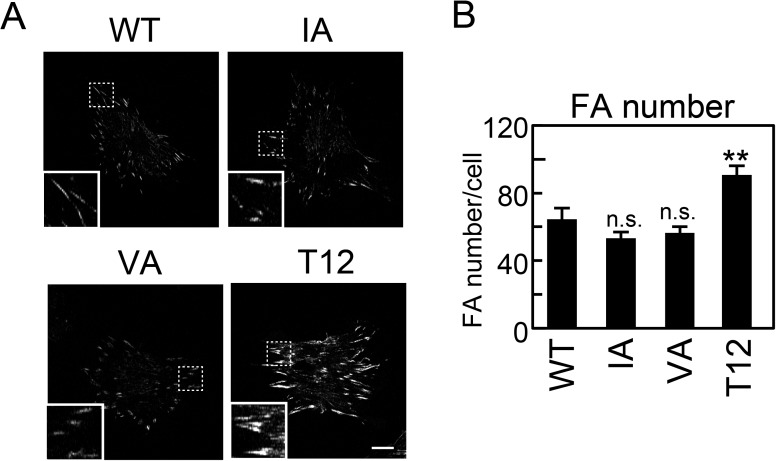
Visualization and quantification of CSB-resistant vinculin mutants.(A) GFP-vinculin-expressing cells cultured on glass coverslips were treated with CSB, then fixed and visualized using GFP. The insets indicate higher-magnification images of the areas indicated with dashed boxes. Scale bar: 20 μm. Thirty individual cells from two separate experiments were photographed for each condition. (B) FA numbers were quantified from (A) using ImageJ. The values represent the means ± S.E.M. Bonferroni’s test (n = 30; **P<0.01; n.s., non-significant).